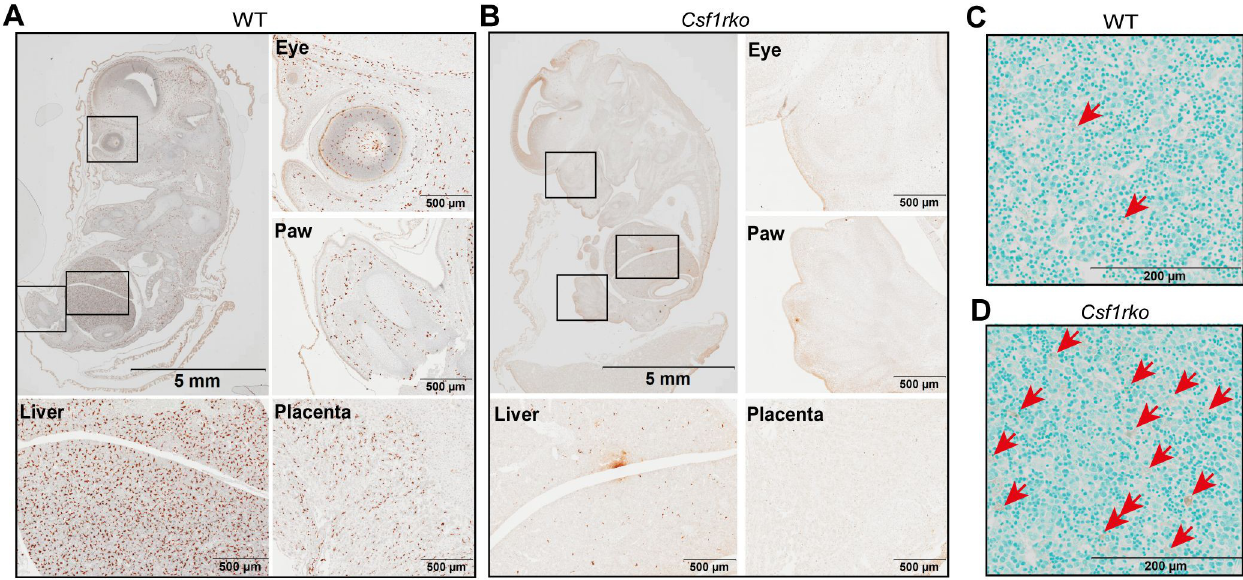
Fig 1. IBA1 expression and TUNEL staining in WT and Csf1rko embryos. (A, B) Histological analysis of IBA1 expression in embryos of (A) WT and (B) Csf1rko rats from the same litter approximately 10.5 days post conception (dpc). IBA1+ cells are detectable throughout the WT embryo and absent from the Csf1rko . The fetal liver, eye and paw (squares) and placenta is shown at higher magnification in the lower panels. Note that early digit condensation is evident in the hind limb of the Csf1rko embryo but there are no infiltrating IBA1 + cells. (C, D) TUNEL staining in the liver of (C) WT and (D) Csf1rko embryos approximately 10.5 dpc. TUNEL + expelled nuclei retained in the Csf1rko liver are highlighted by red arrows.